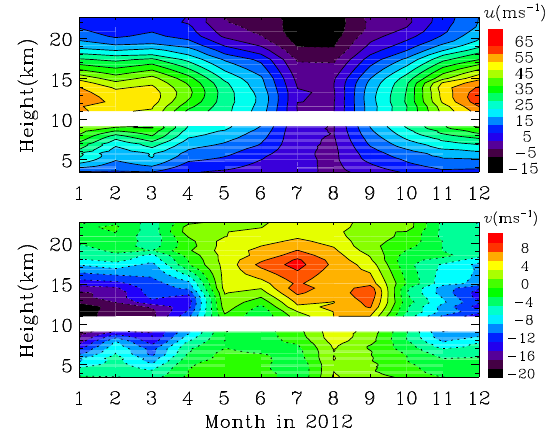
Figure 2. Monthly averaged background zonal wind (top) and meridional wind (bottom) in